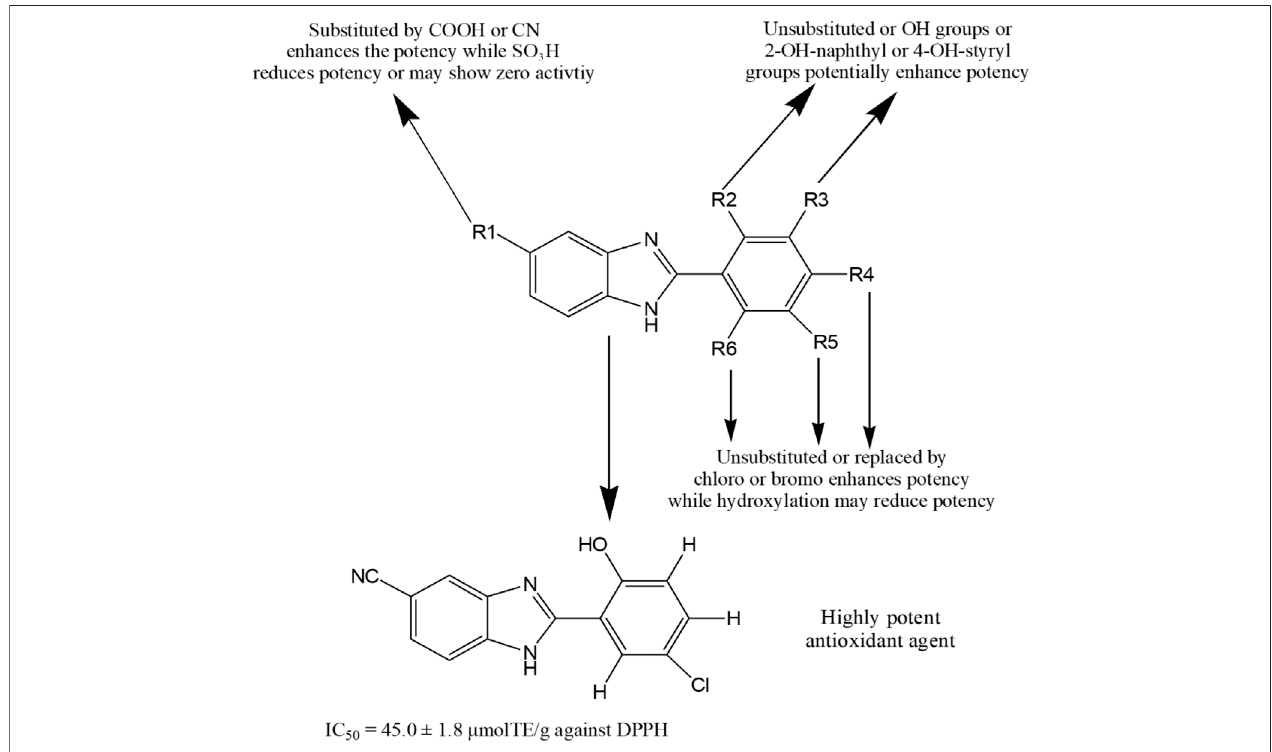
FIGURE 9 | Structure activity relationship (SAR) of benzimidazole derivatives having antioxidant potentiality. The fi gure represents the SAR studies accomplished by Baldisserotto et al. (2020).